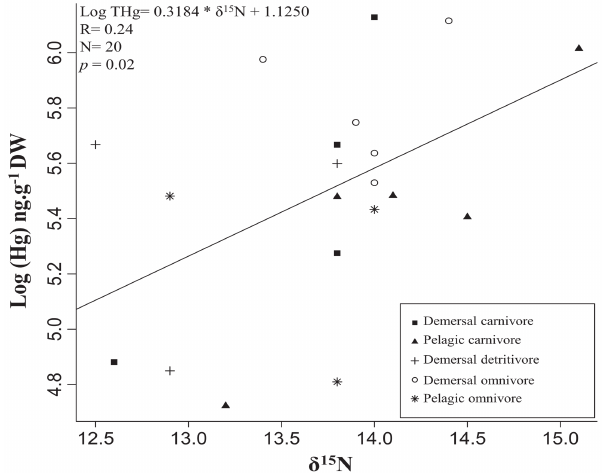
Fig. 4. Relationship between Hg concentrations and δ 15 N values of the trophic guilds of fish of the lower portion of the rio Paraíba do Sul